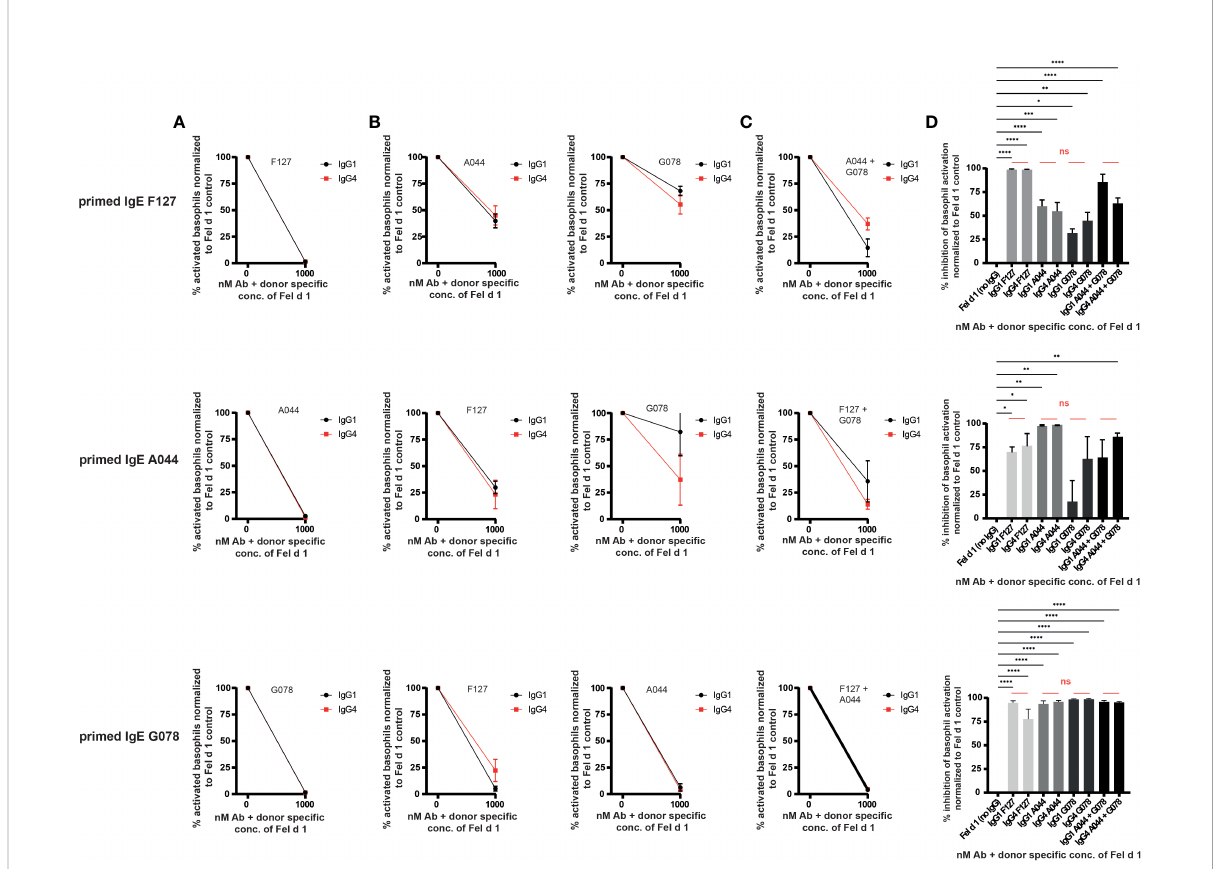
FIGURE 3 IgG1 and IgG4 prevent degranulation by neutralization and signalling via the inhibitory receptor Fc g RIIb. Blood from three non-allergic subjects was collected and primed with Fel d 1 speci fi c IgE. (A) Basophils were primed either with IgE A044, F127 or G078. Primed basophils were treated with recombinant Fel d 1 alone or pre-mixed with the same epitope expressed as IgG1 or IgG4. (B) Basophils were primed either with IgE A044, F127 or G078. Primed basophils were treated with recombinant Fel d 1 alone or pre-mixed with the IgG1 or IgG4 antibodies exhibiting the other two epitopes than the one used for priming. (C) Basophils were primed either with IgE A044, F127 or G078. Primed basophils were treated with recombinant Fel d 1 alone or pre-mixed with a combination of two IgG1 or IgG4 antibodies exhibiting the other two epitopes than the one used for priming. Donor speci fi c Fel d 1 concentrations were evaluated for each IgE priming Ab separately as described in material and methods. Data for each combination is given as mean ± SEM. Activation of basophils of each donor was normalized to activation in the absence of IgG1/4 (=100% activation). (D) % inhibition of basophil activation when basophils were primed either with IgE A044, F127 or G078 and treated with Fel d 1 pre-mixed with either IgG1 or IgG4 antibodies alone or combined [as shown separately in (A – C) ]. Data is given as mean ± SEM. Inhibition of basophil activation of each donor was normalized to inhibition in the absence of IgG1/4 (=0% inhibition). For statistical analysis ordinary ANOVAs were performed. ns (not signi fi cant) for p > 0.05, * for p ≤ 0.05, ** for p ≤ 0.01, *** for p ≤ 0.001 and **** for p ≤